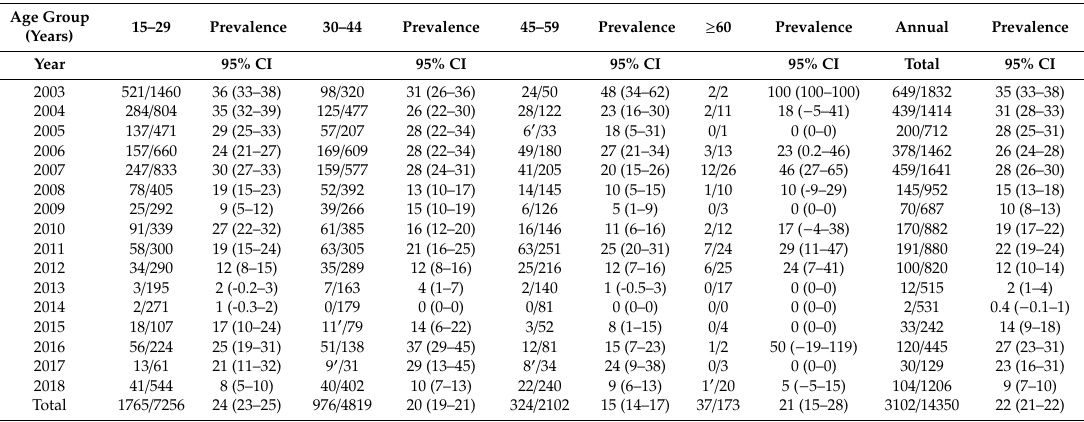
Table A2. The annual distribution of single and co-infections of hepatitis B virus categorized by age groups in East New Britain province from